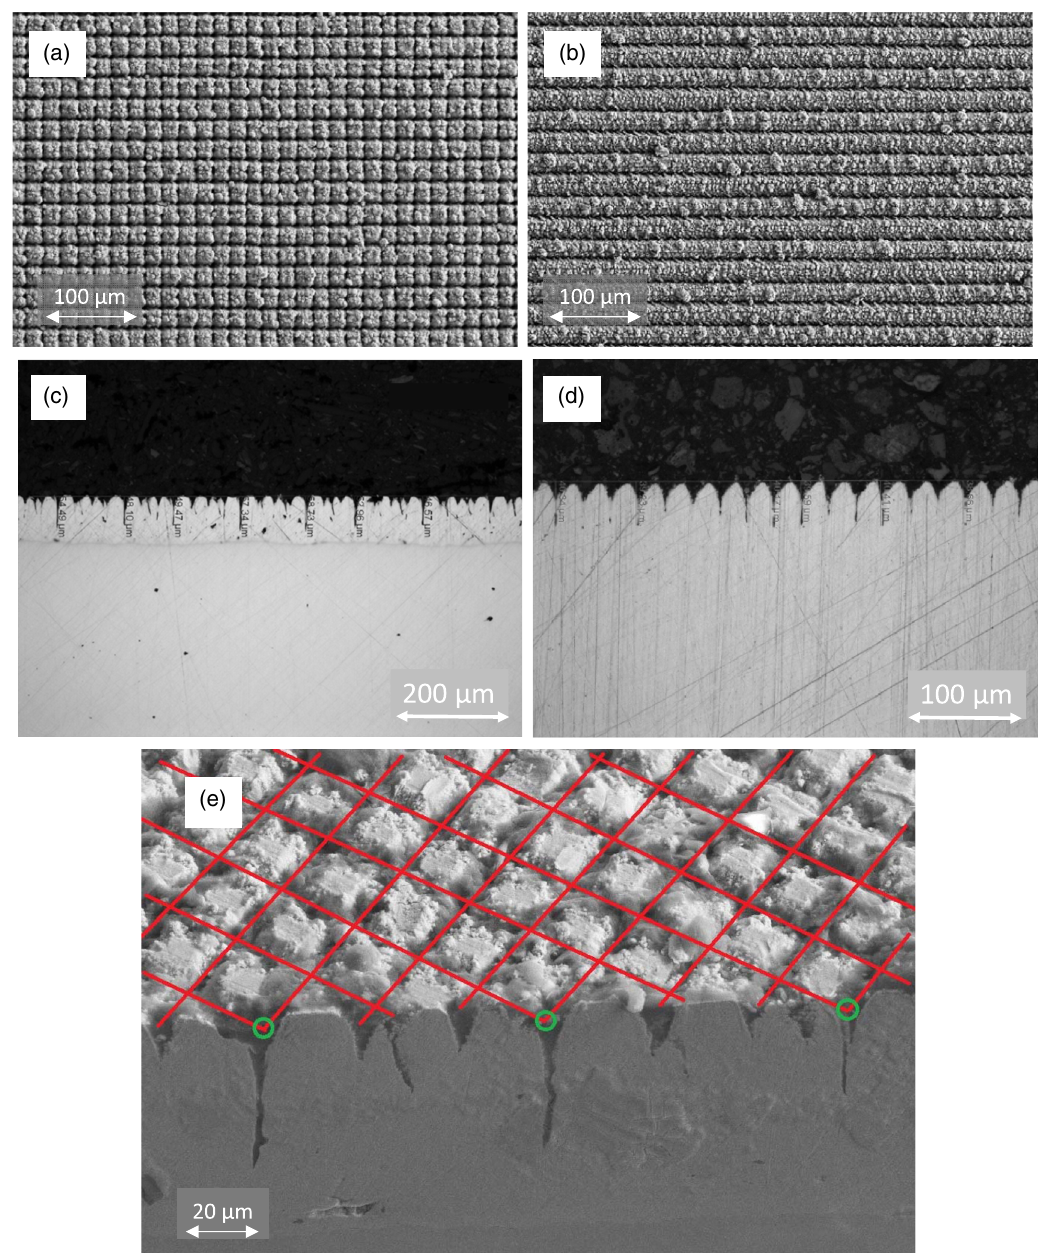
FIG. 3. (a) SEM top view of a Cu sample treated with CH pattern and (b) LH pattern at the University of Dundee. (c) Optical microscope image of a mechanically cut and polished cross section of (a) where the average depth of the grooves is estimated at 53 (cid:1) 5 μ m and (d) cross section of (b), where the average depth of the grooves is estimated at 35 (cid:1) 6 μ m. (e) SEM cross-section image illustrating the larger ablated depth at crossing